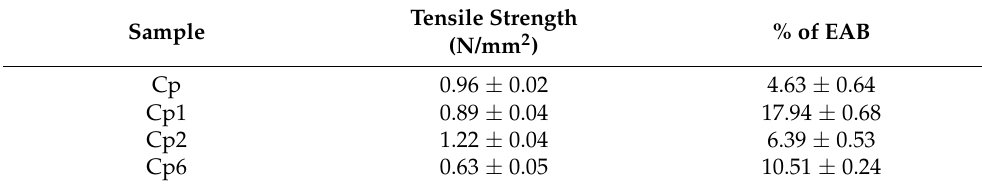
Table 2. Mechanical properties of CH scaffolds.